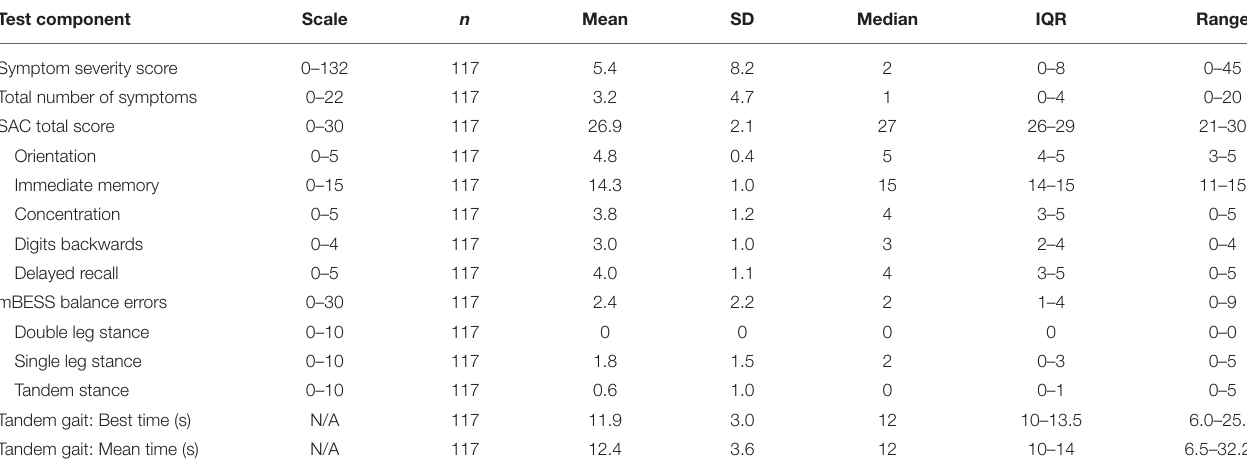
TABLE 2 | Summary of baseline results for women professional rugby league players for each SCAT5 test component.